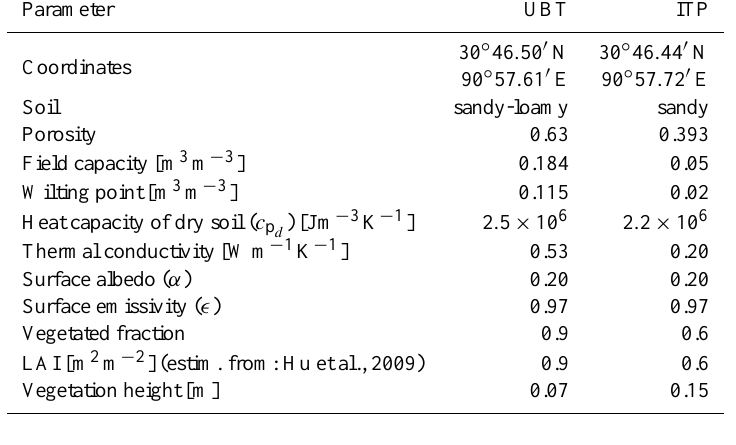
Table 1. Description of the two sites (UBT and ITP) near Nam Co lake and the parameters used the model setup (Biermann et al., 2009).